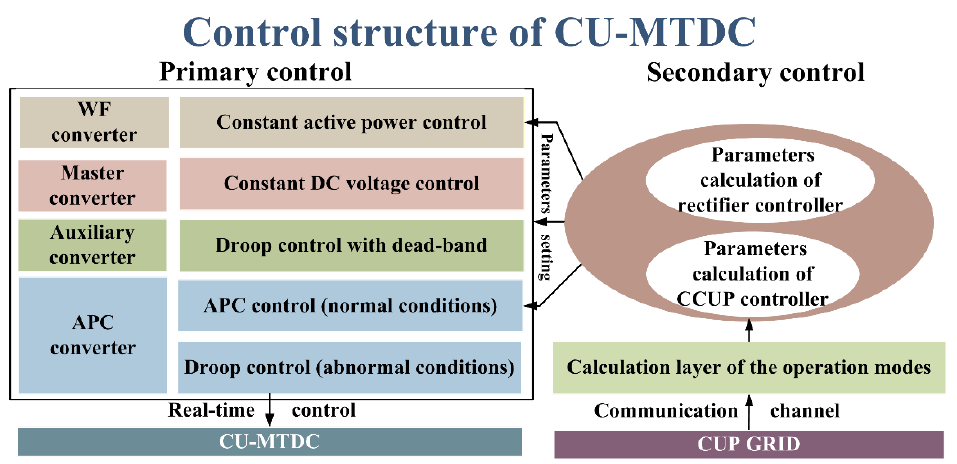
Figure 2. The control structure of CU-MTDC.